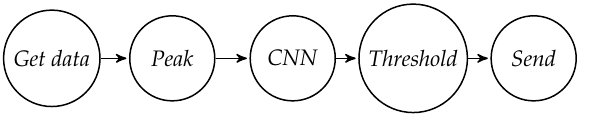
Figure 11. ECG application model for the CNN processing operating mode